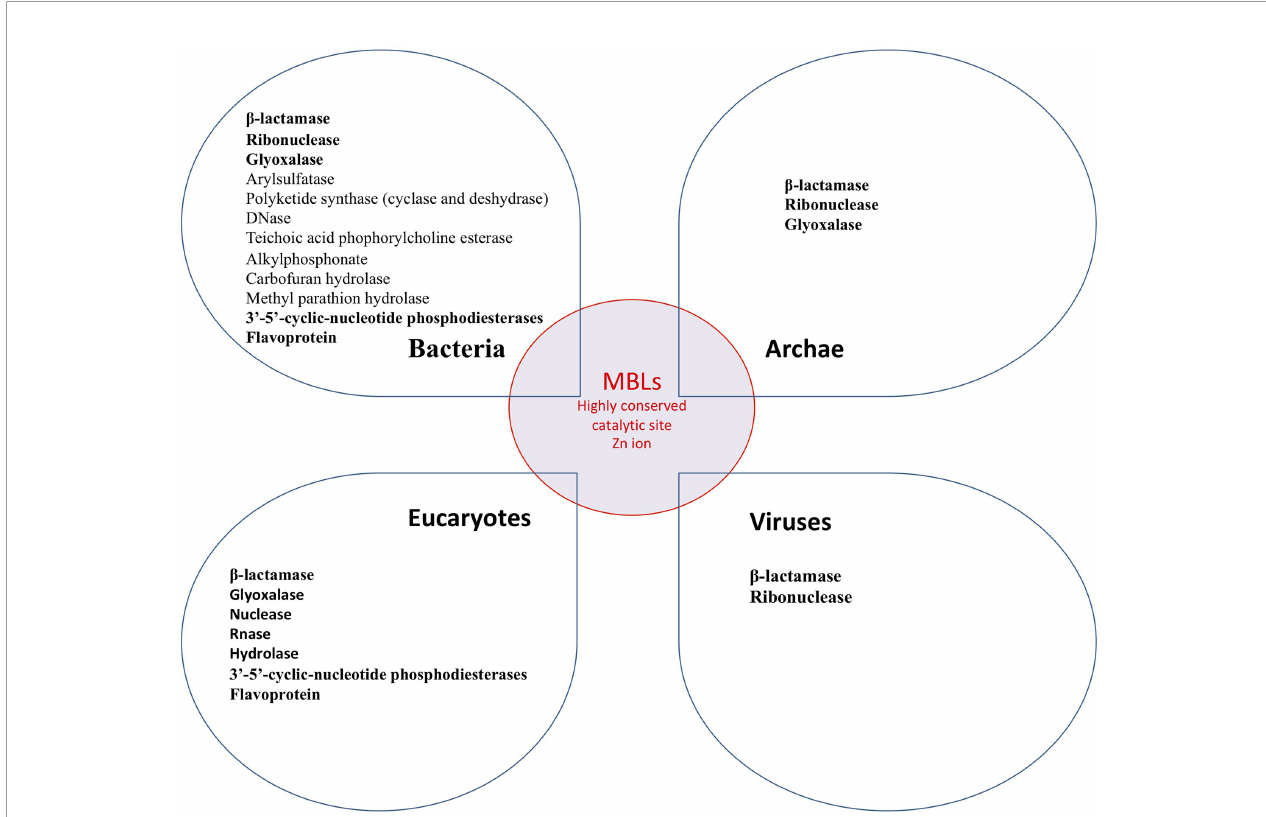
FIGURE 4 | Known MBLs enzymatic activity in the world of life. All these enzymes may be inhibited by b -lactam